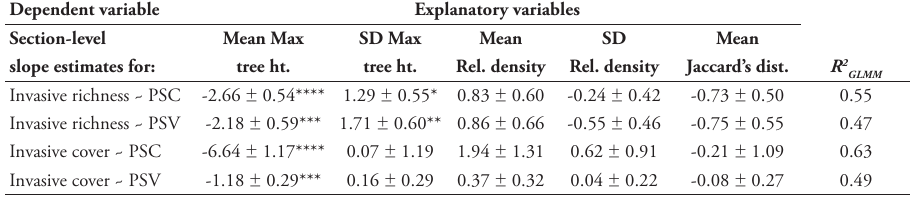
Table 2. Results of linear mixed-effects models. These models were used to determine the relative con- tribution of mean and SD of maximum tree height and relative tree density, as well as mean Jaccard’s dis- tance, to spatial heterogeneity in relationships between metrics of phylogenetic divergence (PSC and PSV) and invasion (invasive richness and cover). Models contained ecological provinces as a random